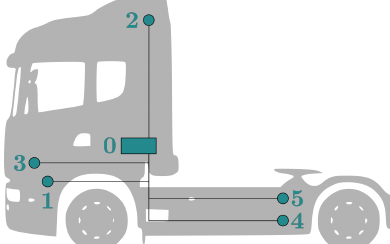
Figure 1. Diagram of a tractor with the location of the different measuring systems installed on the vehicle depicted in green. (1) CAN-bus sensor, (2) GPS antenna, (3) Air pressure sensor, (4) Tempera- ture sensor, and (5) Exhaust sensors of NO x and O 2 . (0) Indicates the location of the onboard unit system responsible for logging the